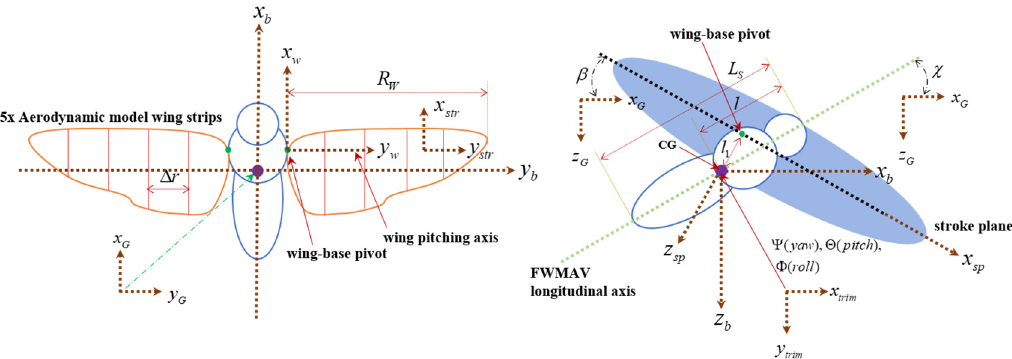
Figure 1. FWMAV multibody model and coordinate systems.